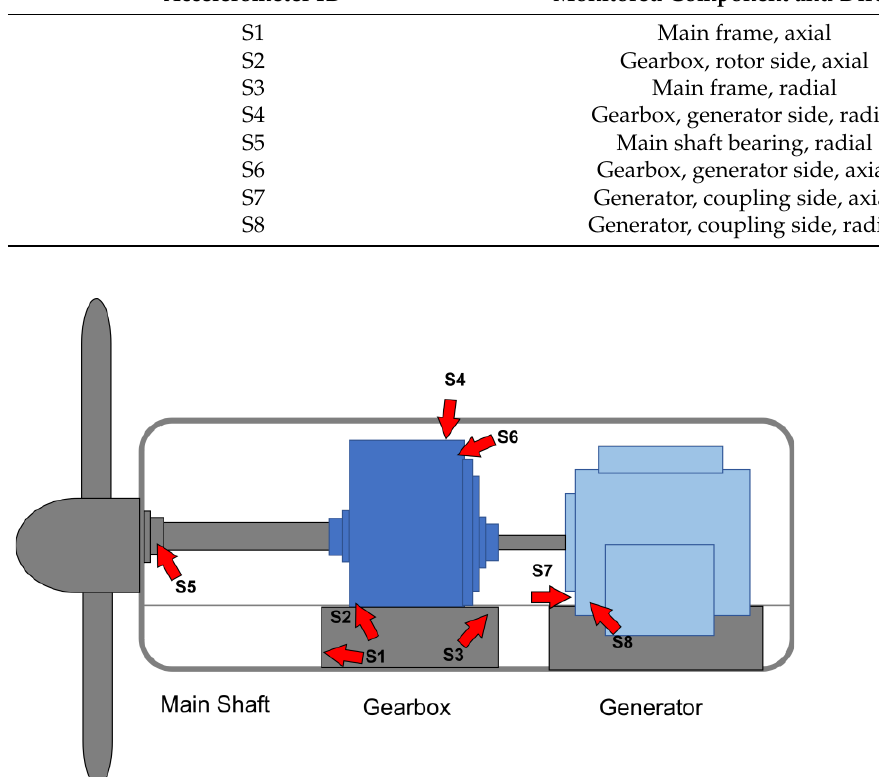
Figure 3. Sketch of the drivetrain of the two wind turbines. The accelerometers S1 – S8 are indicated in red.